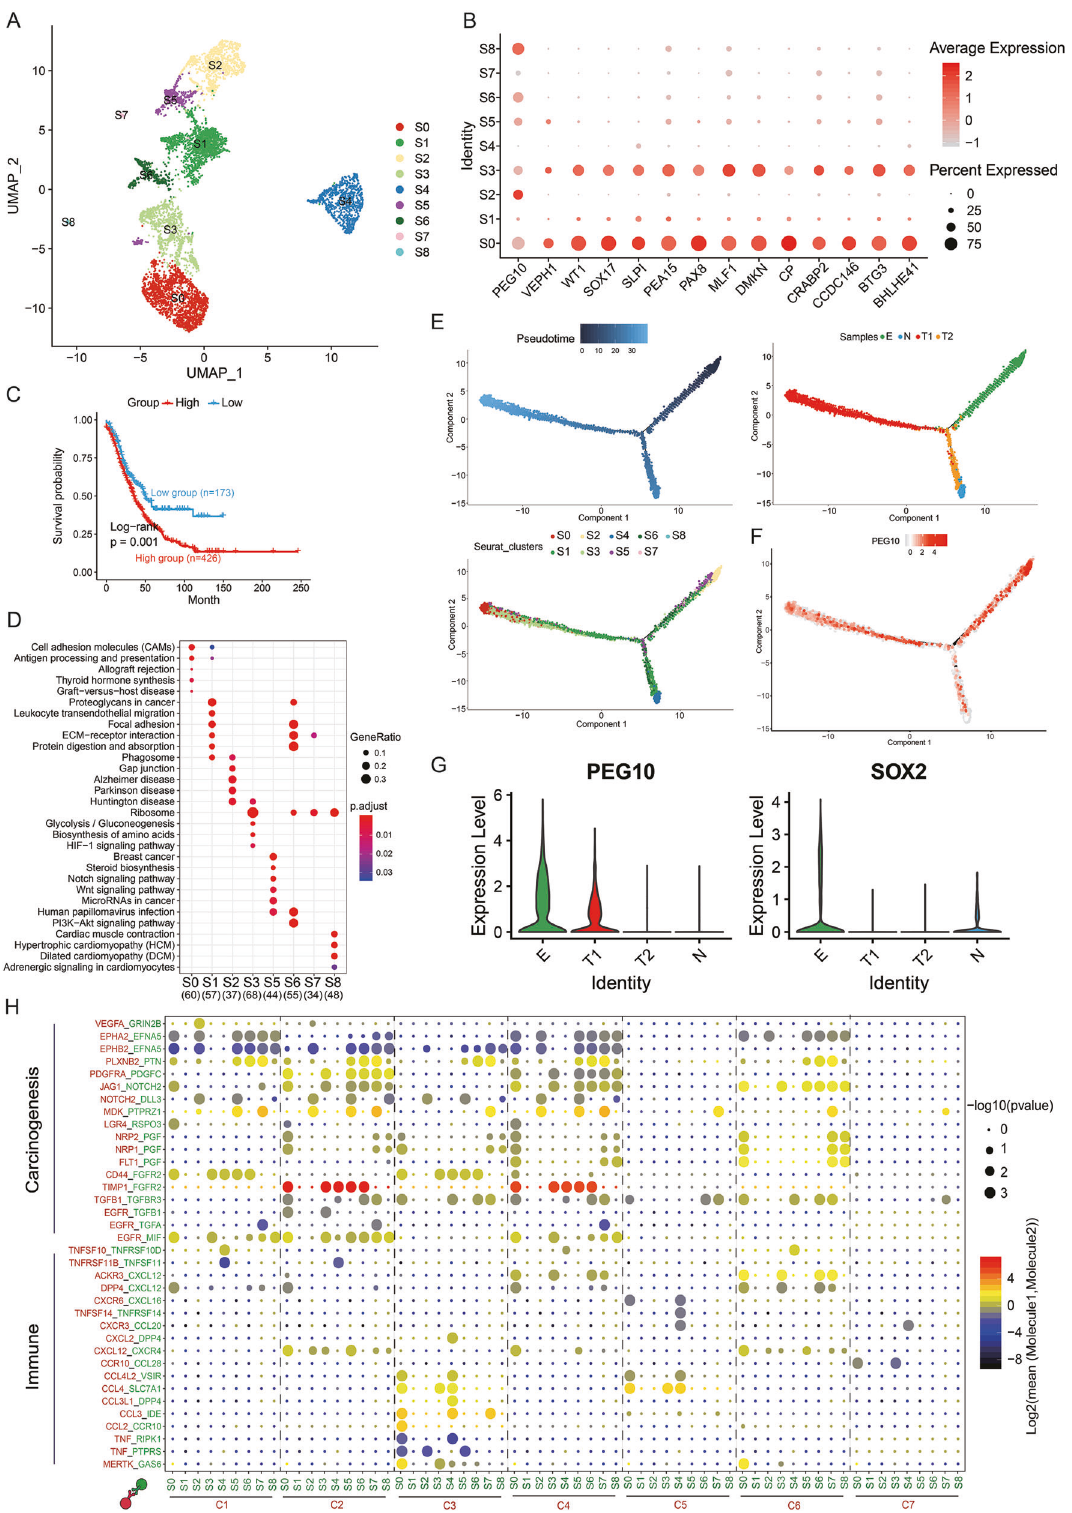
Fig. 3 Differential gene expression pro fi les of diverse clusters of C0. A UMAP representation of nine subgroups generated from C0. B Dotplot illustrating the representative genes across diverse cell types. C Kaplan – Meier curves for patients with high- and low-GSVA score (based on top 100 markers of S3) in GEO OC meta data sets (Log-rank p = 0.0099). D Functional analysis of each subtype is illustrated with KEGG. E Pseudotime of nine subtypes and four samples in C0 inferred by Monocle2. Each point corresponds to a single cell. Clusters or samples information are shown. F Expression of PEG10 was mapped to the single-cell trajectory plot. Colour from grey to red indicates relative expression levels from low to high. G Violin plots illustrating the mRNA levels of PEG10 and SOX2 in samples based on cells in S3. H Heatmap of selected ligand – receptor interactions between diverse cell types and subtypes of C0. Point size indicates p value (CellPhoneDB). Colour indicates the mean expression level of ligand and receptor (Mol1/2). Cell Death and Disease (2021)